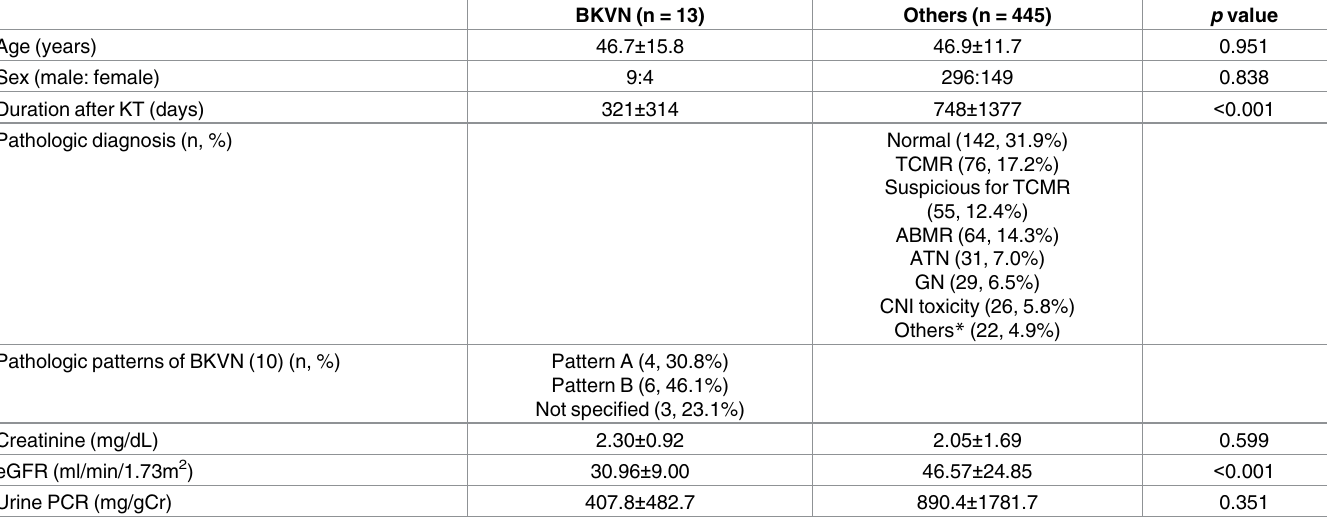
Table 1. Clinical characteristics of patients with BK virus nephropathy and other kidney transplant